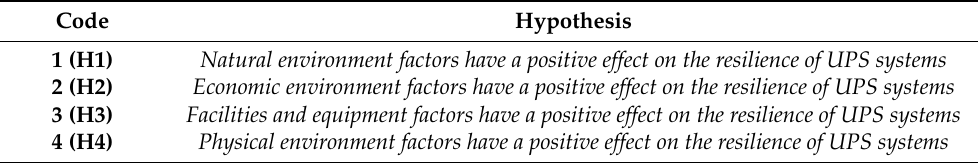
Table 2. The four research hypothesis statements.